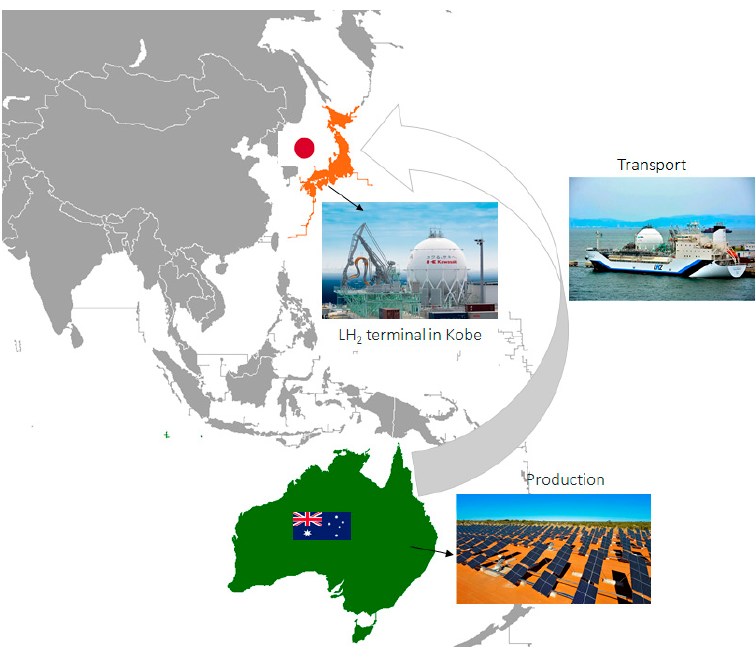
Figure 3. Liquefied green hydrogen shipping by Suiso Frontier from a port in Victoria, Australia, to Kobe, Japan.